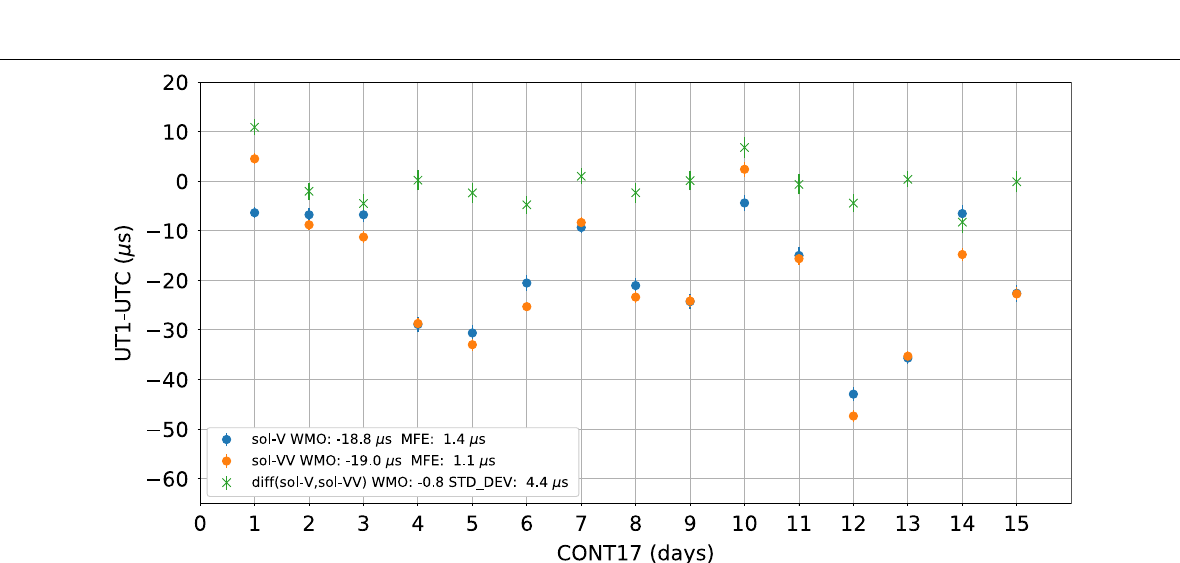
Fig. 12 UT1 estimates and differences between sol‑V and sol‑VV. Presented are weighted mean offset (WMO) and mean formal error